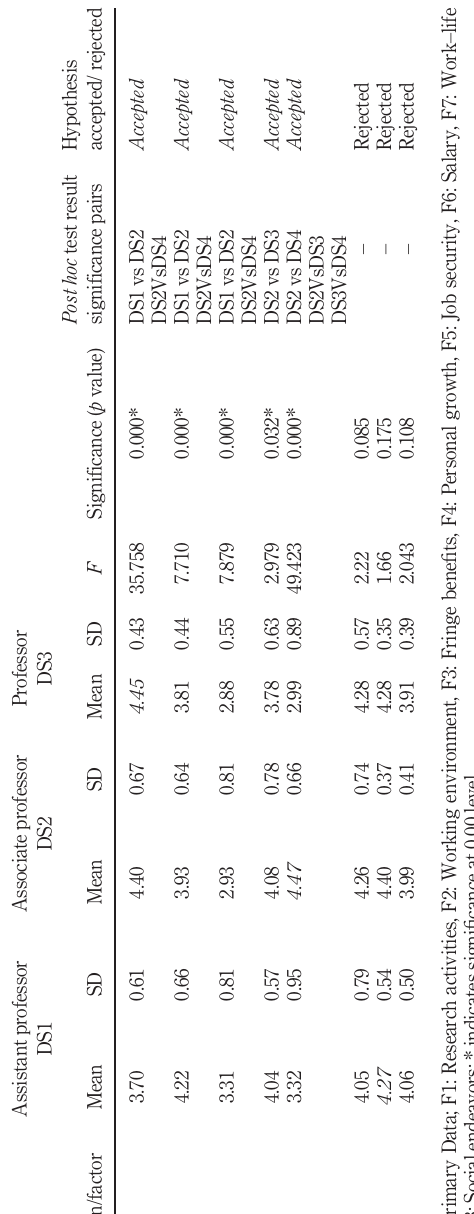
Table VII. Designation-wise comparison of